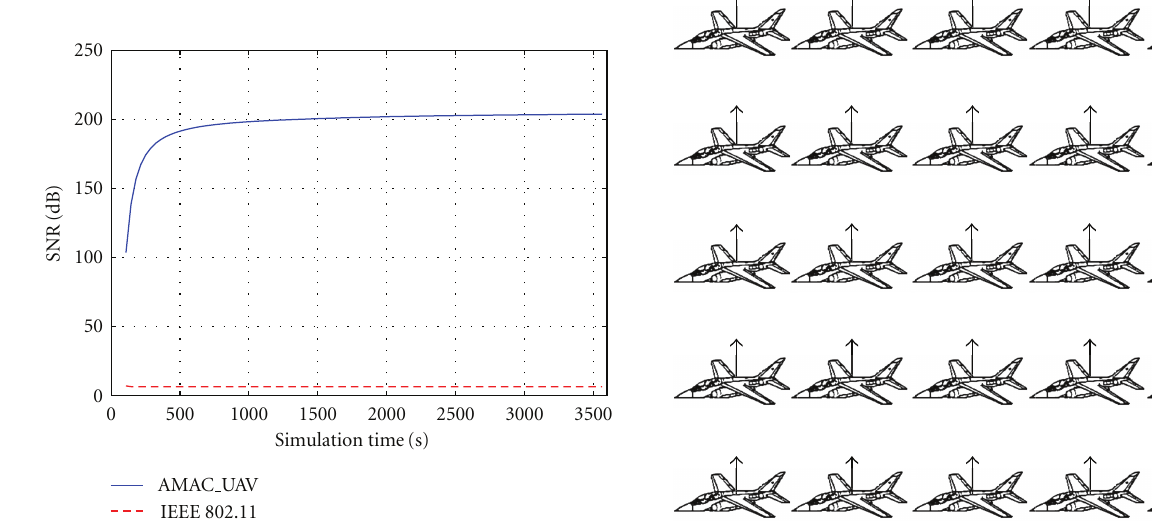
Figure 10: Receive SNR of a MANET of 4 UAVs.